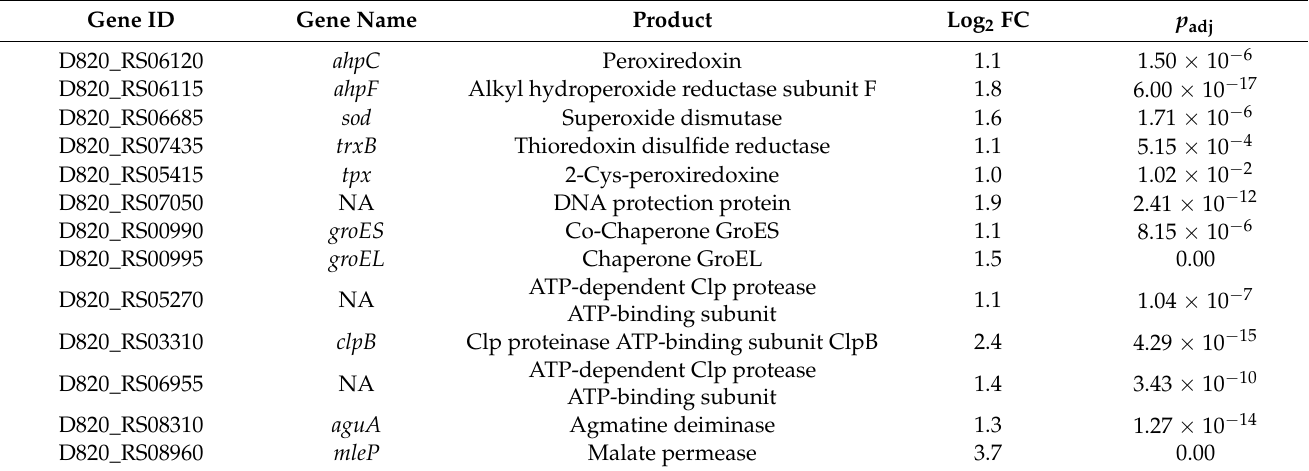
Table 3. Differentially expressed genes in S. mutans upon CHX treatment related to stress